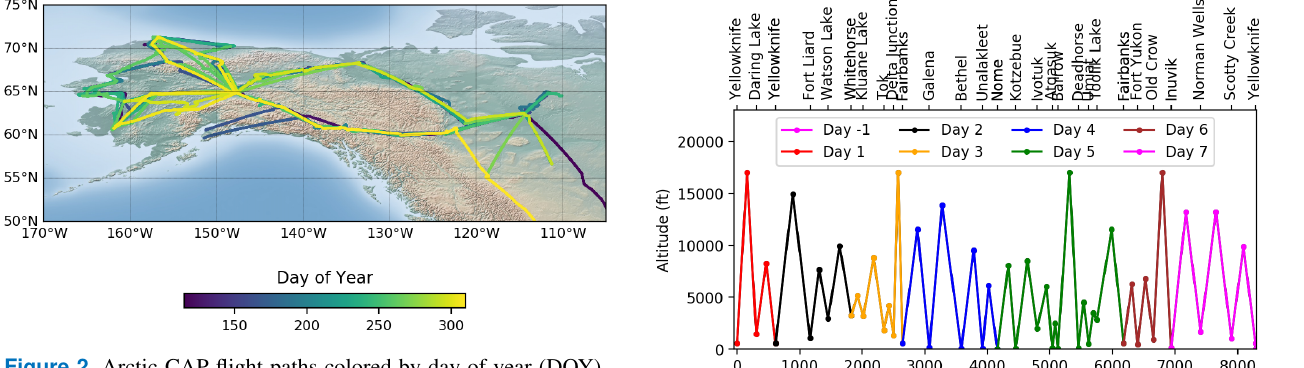
Figure 2. Arctic-CAP flight paths colored by day of year (DOY). Later paths are plotted on top, masking flights from earlier in the year along the same routes. Profile locations span 50–75 ◦ N and 105–165 ◦ W and sampled environmental conditions from the spring thaw ( ∼ DOY 125) through the early cold season ( > DOY 300) (© Google Maps).